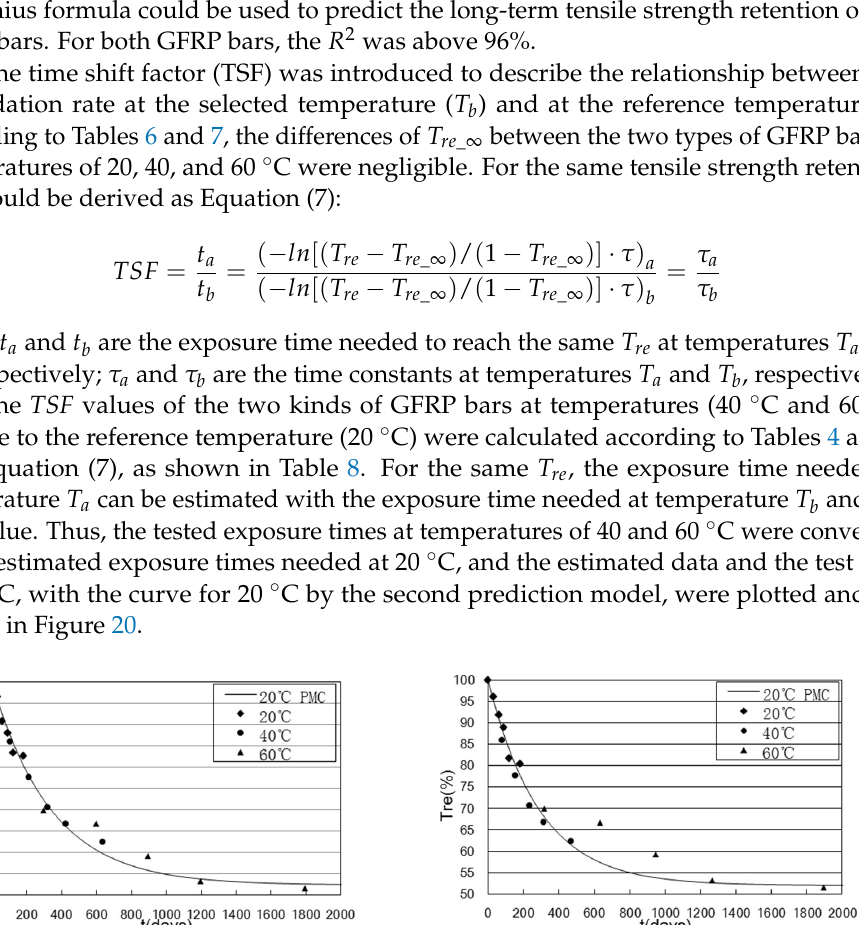
Figure 20. Estimated data and test data at 20 °C with the curve for 20 °C by the second model: ( a ) G1; ( b ) G2.